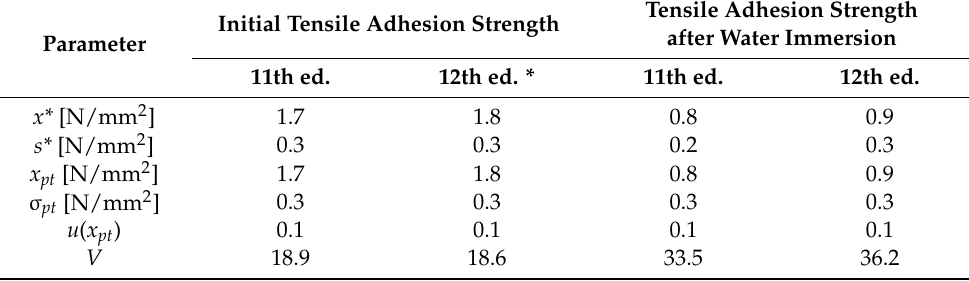
Table 4. The value of statistical parameters calculated following ISO 13258 [48] for measurements of CTA initial tensile adhesion strength and tensile adhesion strength after water immersion during the eleventh and twelfth editions of the